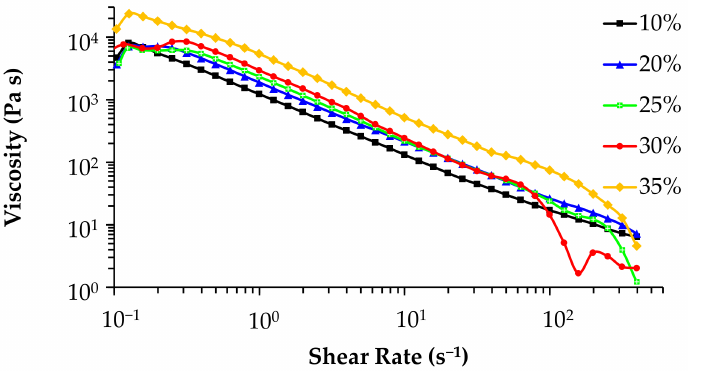
Figure 2. Dependence of the flow properties (viscosity vs. shear rate curves) on solid